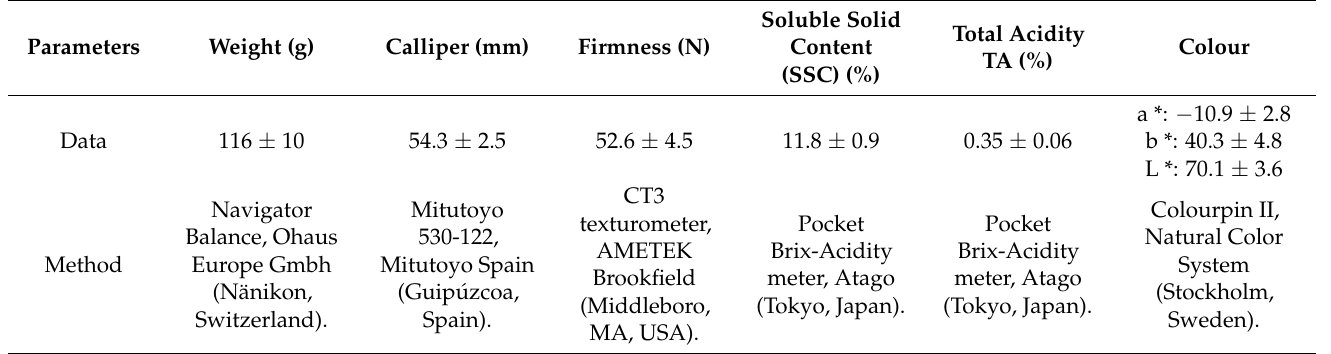
Table 1. Harvest indexes. The means ± standard error of the means (SEM) are shown. n =